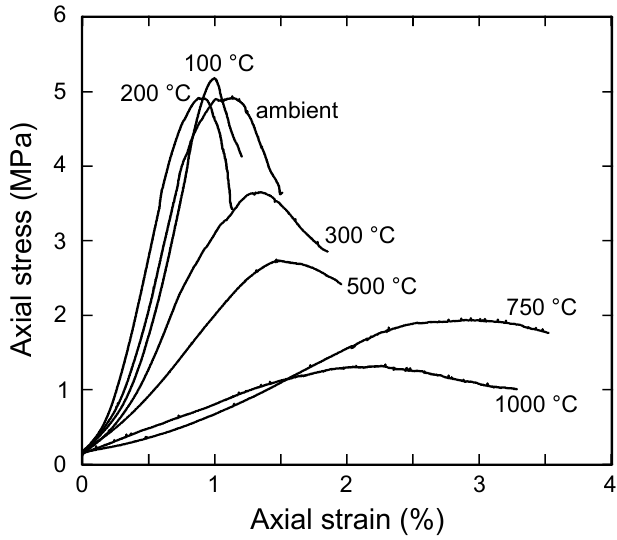
Figure 5: Uniaxial stress-strain curves for samples of Mt. Epomeo Green Tu ff (MEGT). Temperature next to each curve corresponds to the thermal stressing tem- perature. “Ambient” (i.e. ambient temperature) indi- cates a sample that underwent no thermal